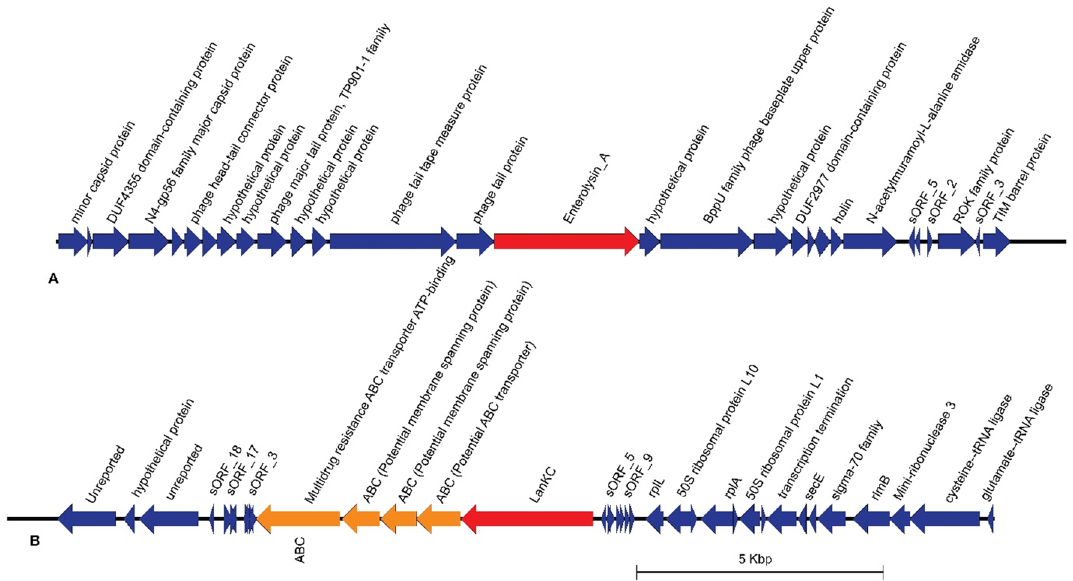
Figure 7. Putative area of interest (AOI) for the predicted bacteriocin in Pediococcus acidilacti . ( A ) C3 contains Enterolysin A class bacteriocin and ( B ) G11 contains Lanthipeptide class IV